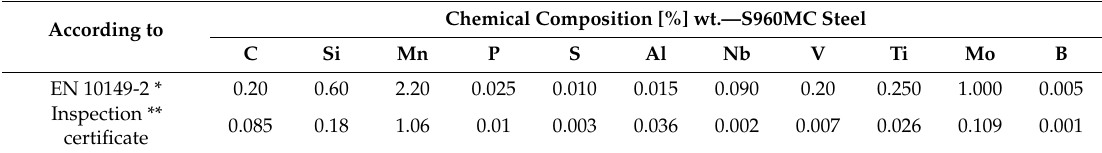
Table 1. Chemical composition of investigated